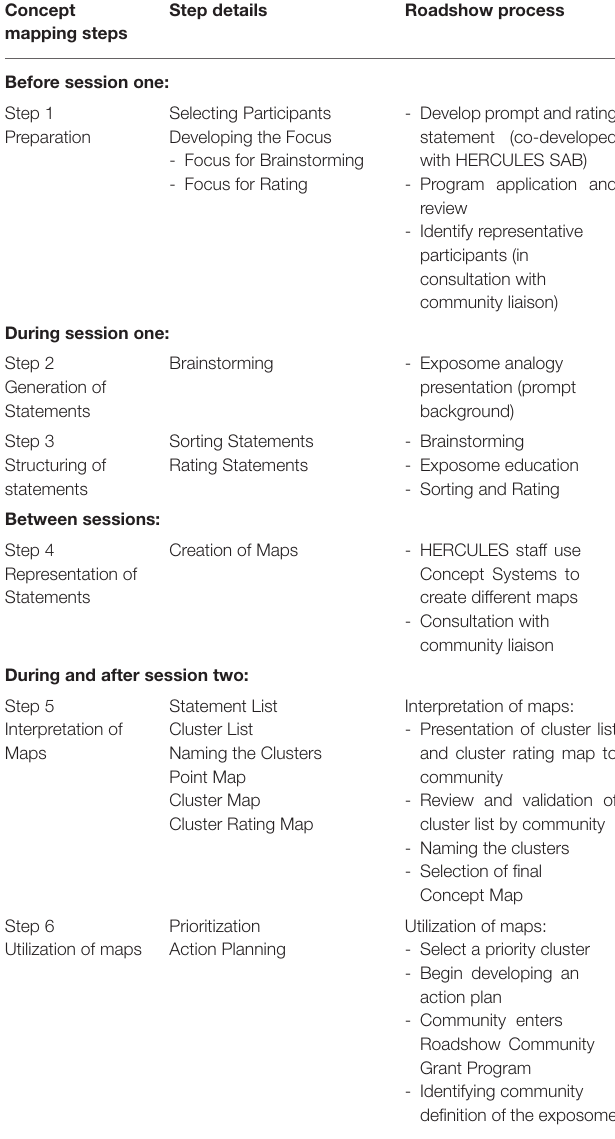
TABLE 1 | Concept mapping steps [adapted from Trochim